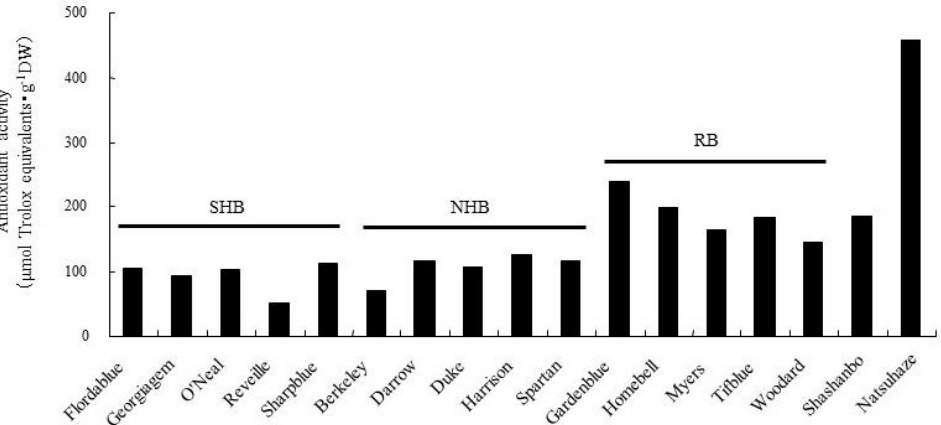
SHB: Southern highbush blueberry. NHB: Northern highbush blueberry. RB: Rabbiteye